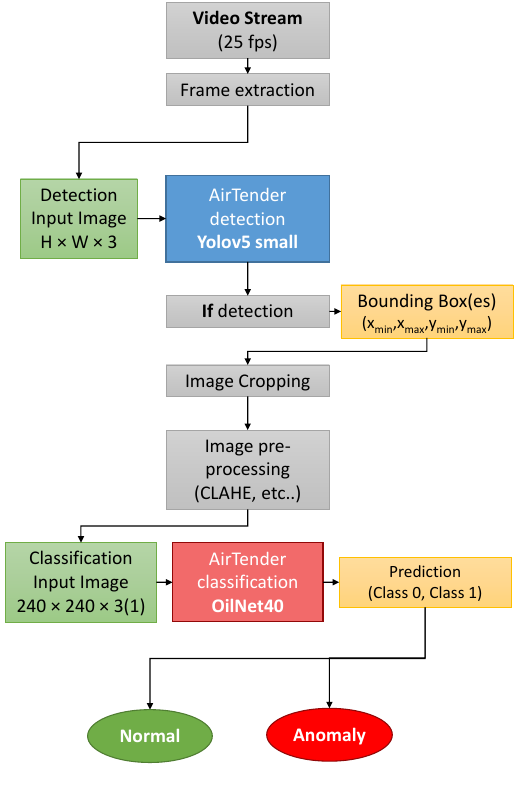
Figure 5. Summary of the key processes to spot oil leaks.